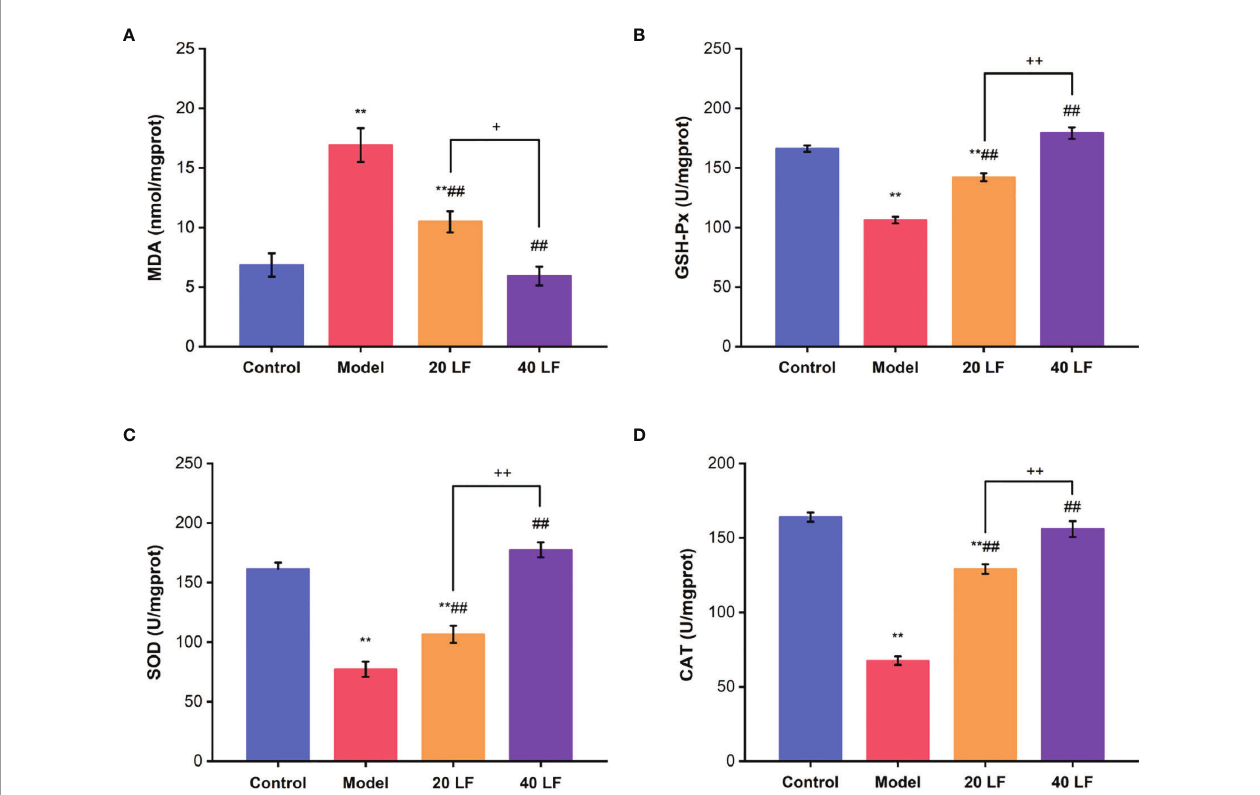
FIGURE 4 | Effects of LF on the MDA levels (A) , GSH-Px, SOD, and CAT activities GSH-Px (B) , SOD (C) , and CAT (D) of the spleen ( n = 8). ** P < 0.01 vs control; ## P < 0.01 vs model, * P < 0.05, ++ P < 0.01 compared between 20 LF and 40